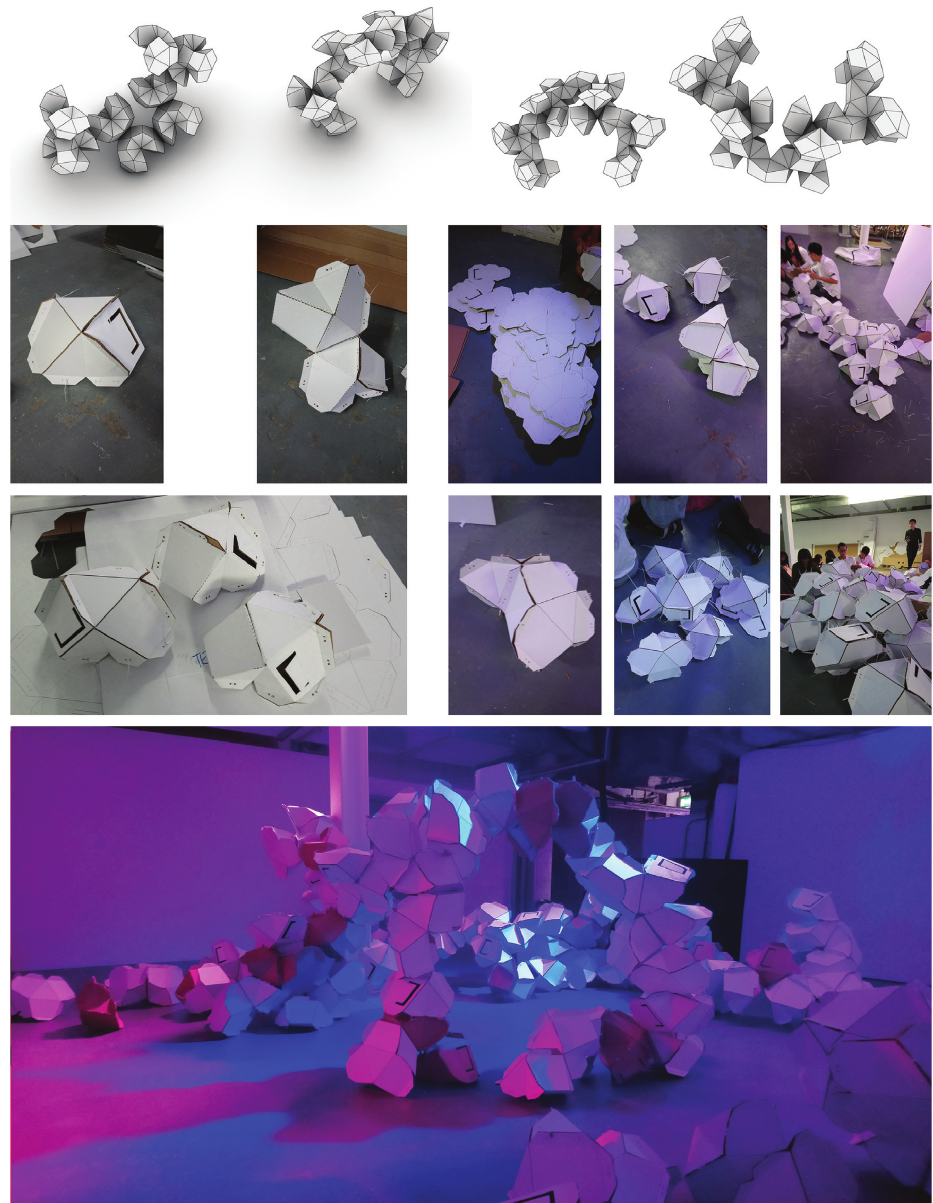
Figure 1: The Fish Trap installation consisting of predefined precut components. The intervention was built on-site based on improvisation and collaborative design strategies. The possible spatial scenarios had been simulated computationally using stochastic aggregation strategies. The designer designed the building block only, which allows builders to build an endless variety of